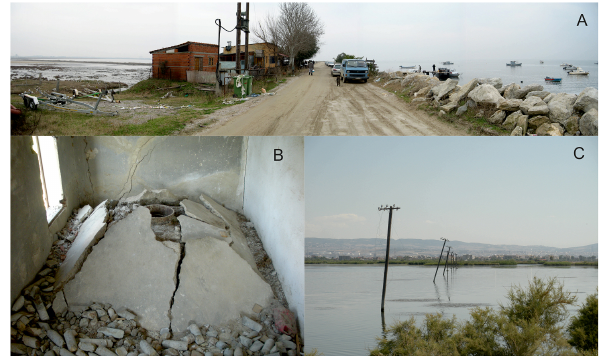
Figure 2. Field evidences of subsidence: (a) top view of the em- bankment proving that the sea level (right) is higher than the inland surface (left); (b) pipe’s extraction in a deep well North of Kalochori and (c) submerged electricity network SW of